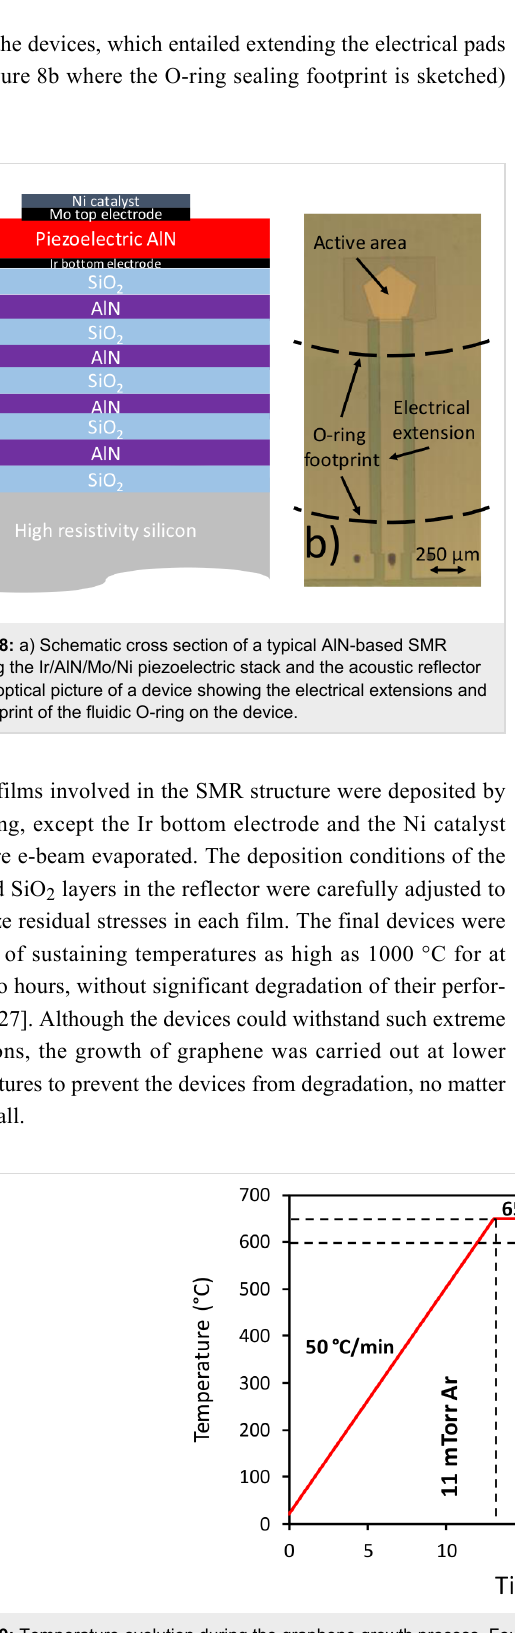
Figure 9: Temperature evolution during the graphene growth process. Four stages are represented, corresponding to the sample heating in pure Ar atmosphere, the C 2 H 2 supply (diluted in Ar), the slow cooling in pure Ar atmosphere, and the fast cooling, also in Ar atmosphere.